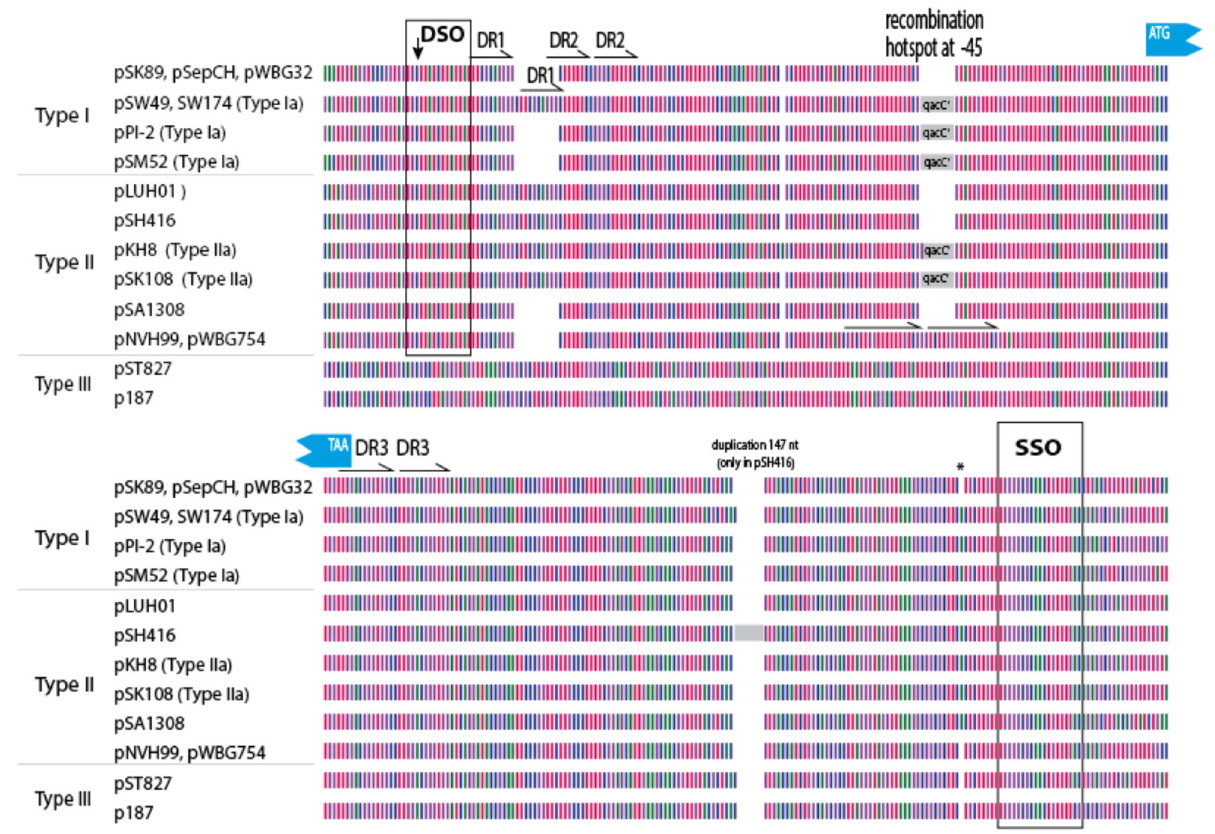
FIGURE 2 | Graphical representation of 200 qacC upstream (top) and downstream (bottom) sequences. Nucleotides are represented by color with A (red), T (purple), G (green), and C (blue). DSO, double-strand origin of replication; DR, direct repeat; SSO, single-strand origin of replication. Other features indicated are discussed in the